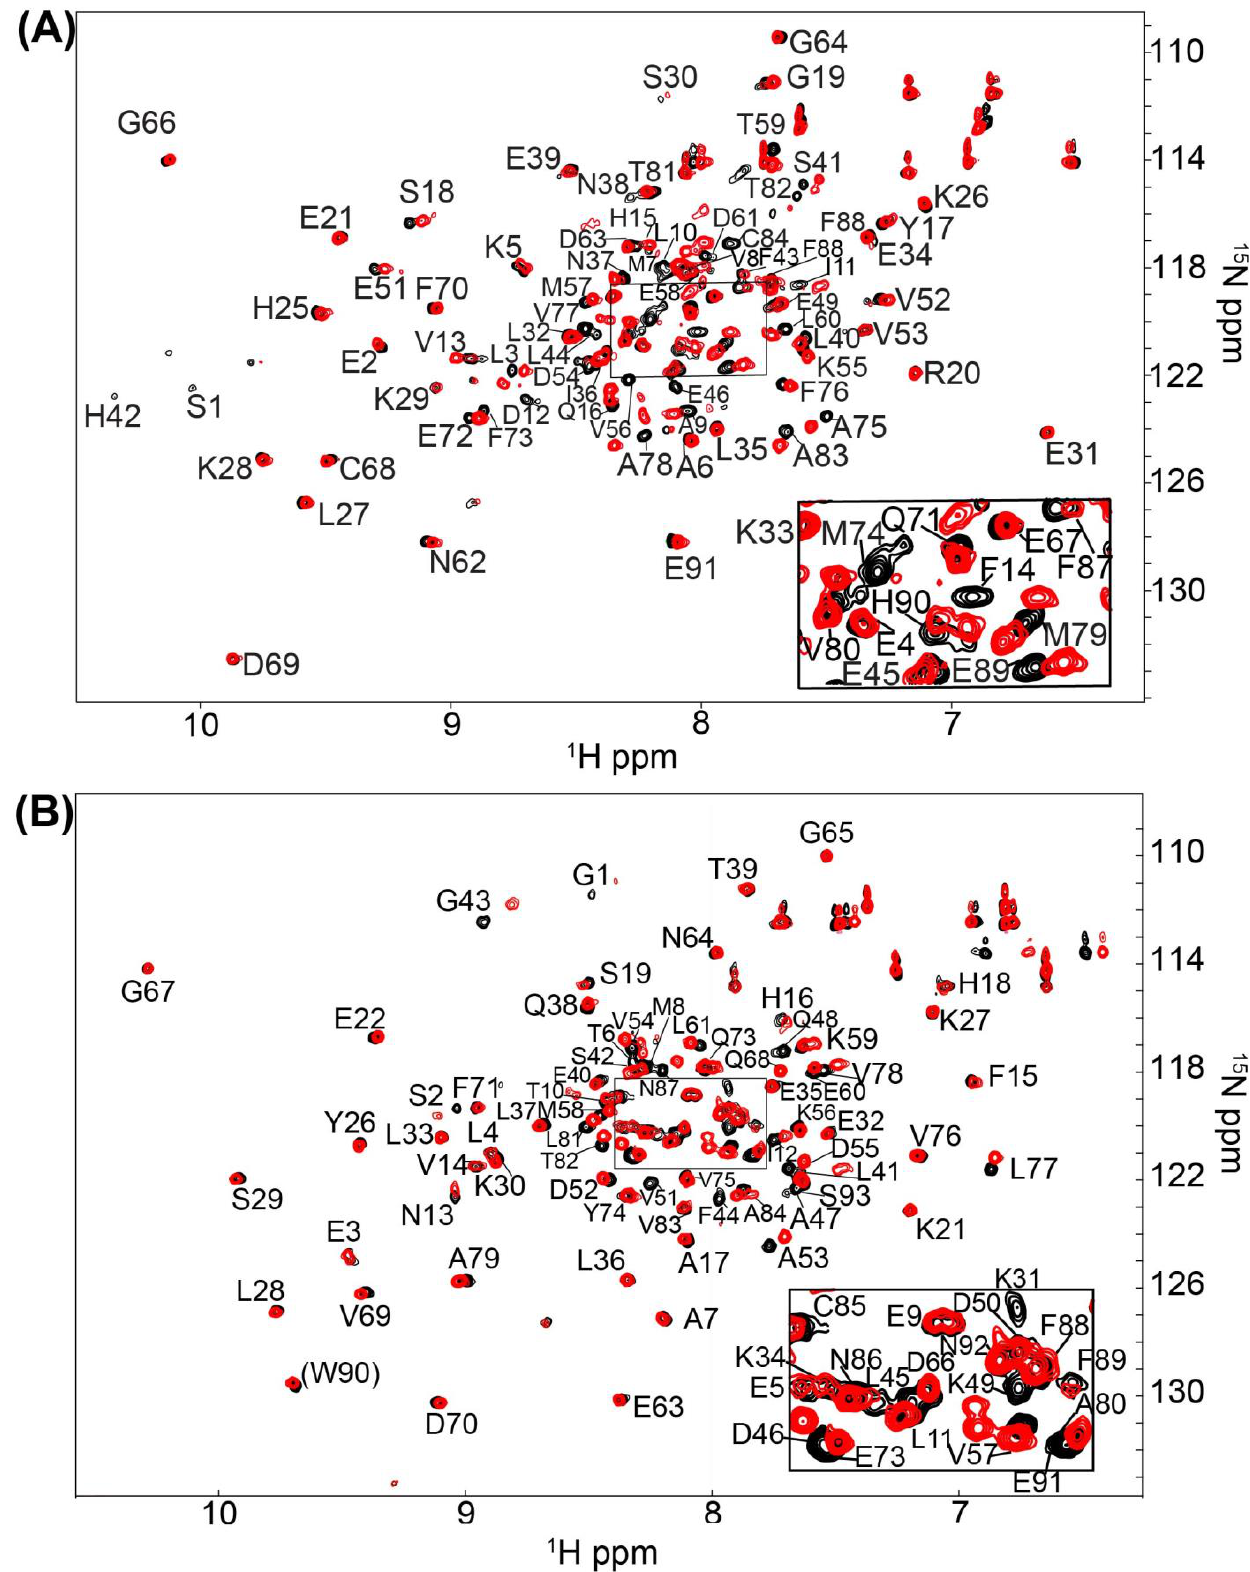
Figure 3. NMR data of S100B and S100A1 bound to the non-specific inhibitor BTB10184. 2D-[ 1 H- 15 N] HSQC overlays of ( A ) Ca 2+ -S100B and ( B ) Ca 2+ -S100A1 with (red) and without (black) the nonspecific compound BTB10184. The NMR data was collected in the same manner for both S100 proteins under identical buffer conditions, at 800 MHz, 37 °C, as described in Methods.